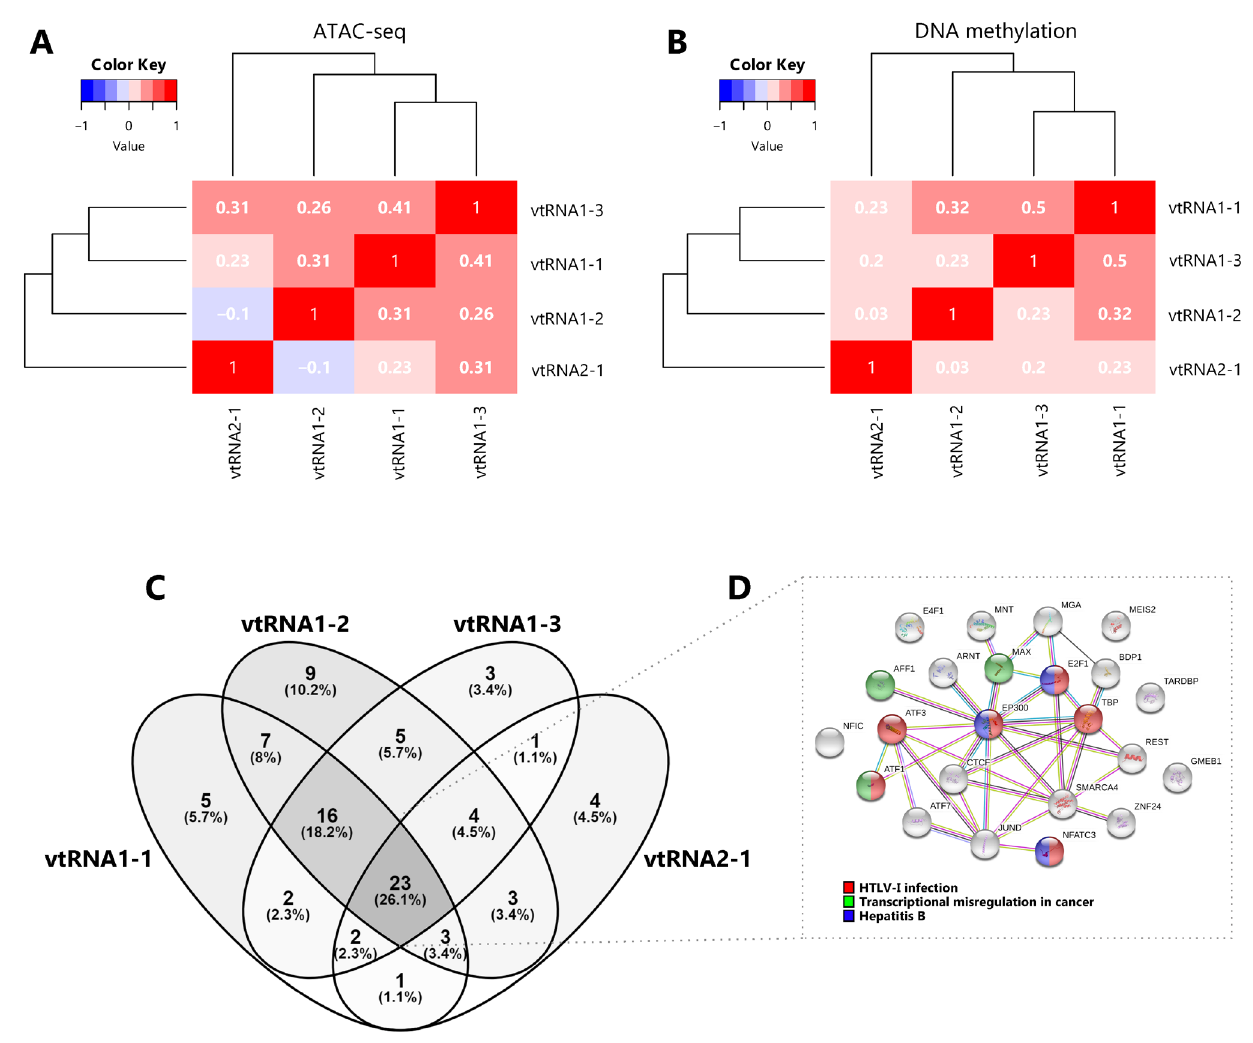
Figure 3. Comparative chromatin accessibility and transcription factor occupancy at the vtRNA loci. A–B Matrix of pairwise Spearman correlations (two-way hierarchical clustering distance measured by Euclidean and Ward clustering algorithms) of vtRNA 500 bp promoter region for ATAC-seq data (385 primary tumors samples across 23 tissues) ( A ) and DNA methylation average beta-values data (8403 primary tumors samples across 32 tissues) ( B ). C. Venn diagram of transcription factors identified as ChIP-seq Peaks by ENCODE